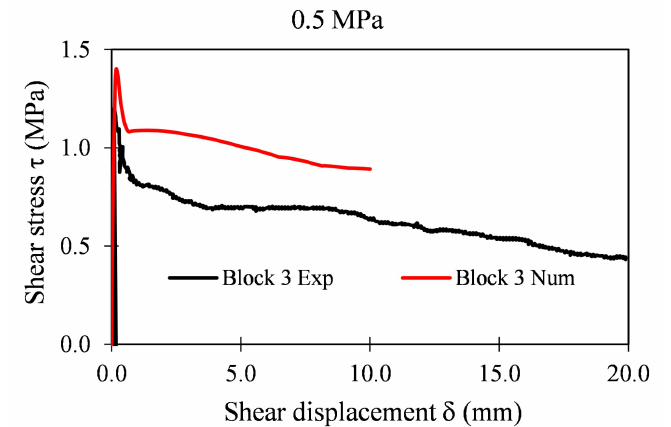
Figure 26. Shear stress evolution with displacement Exp–Num (Block 3).